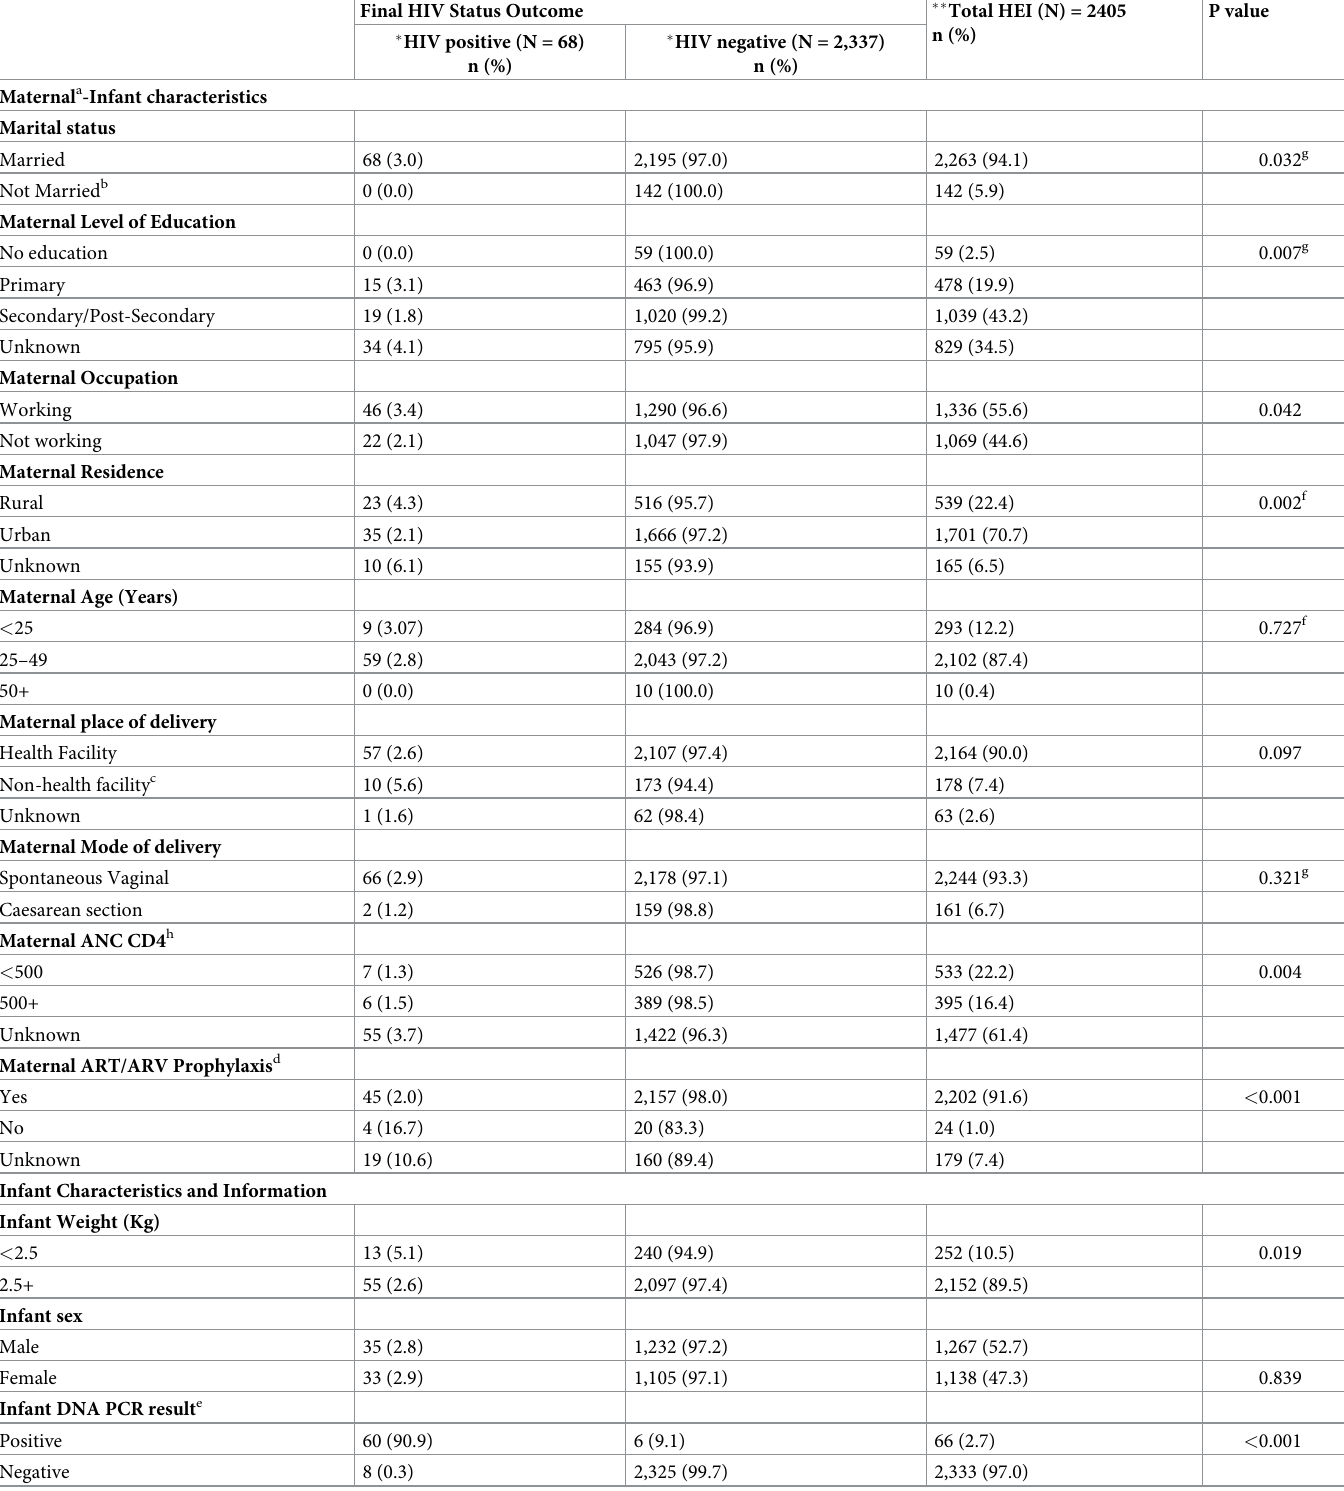
Table 2. Socio-demographic and clinical characteristics of mother-infant